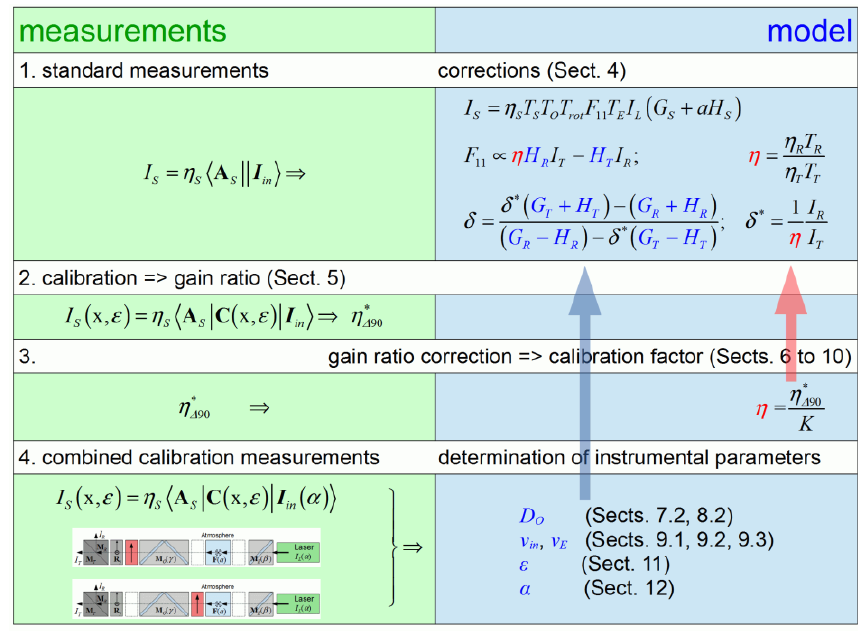
Figure 4. Four steps for calibrating and correcting the standard measurements for systematic errors by means of the model equations and additional calibration measurements. On the left side the measurements and their Müller matrix representations are listed and on the right side the scalar equations and their parameters, which can be retrieved from our model and from additional calibration